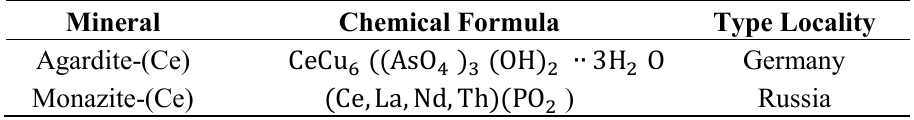
Table 5. Several members of the rare earth phosphates. Modified after